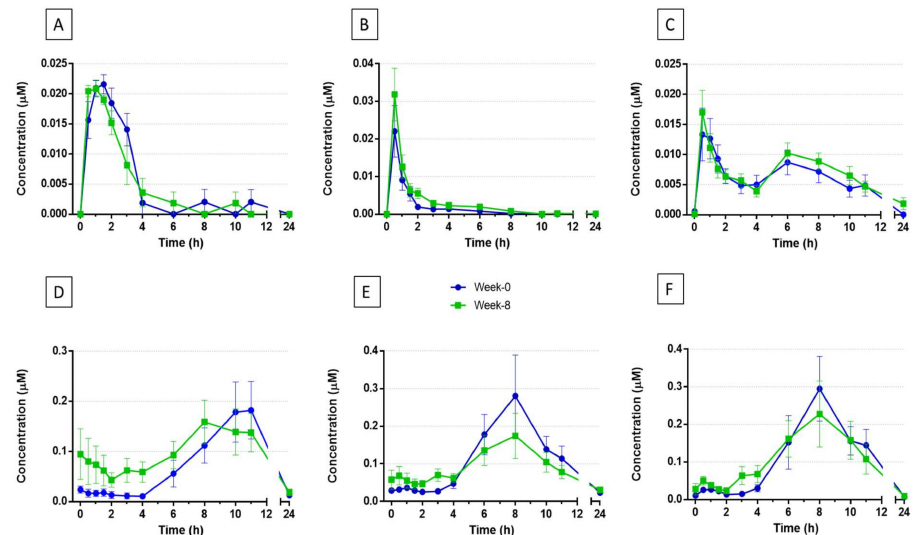
Figure 2. Plasma kinetic profile of ( A ) 5-caffeoylquinic acid, ( B ) isoferulic acid, ( C ) 3 (cid:48) - methoxycinnamic acid-4-sulfate, ( D ) 3-(3 (cid:48) ,4 (cid:48) -dihydroxyphenyl)propanoic acid, ( E ) 3-(4 (cid:48) -hydroxy-3 (cid:48) - methoxyphenyl)propanoic acid, and ( F ) 3-(3 (cid:48) -hydroxyphenyl)propanoic acid-4 (cid:48) -sulfate after con- sumption of a nutraceutical containing 300 mg of hydroxycinnamic acids. Values are means ± SEMs ( n = 9). Blue lines: week 0 of the intervention. Green lines: week 8 of the